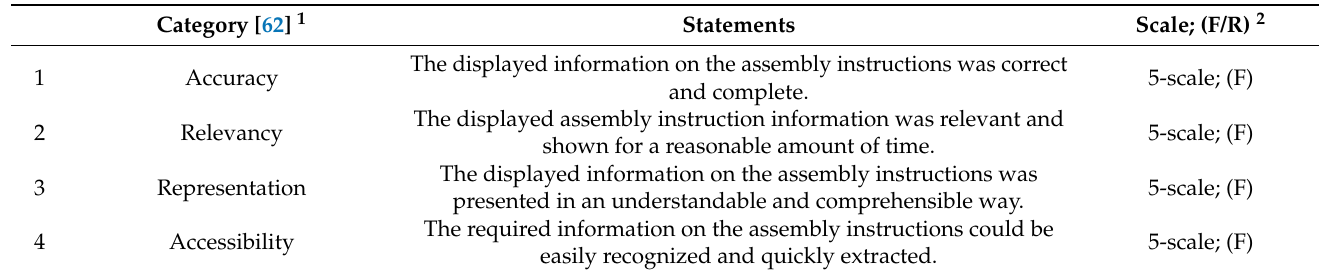
Table A6. Quality of provided information questionnaire (one representative item for each informa- tion quality categories suggested by [62], based on the information quality items in [63]).